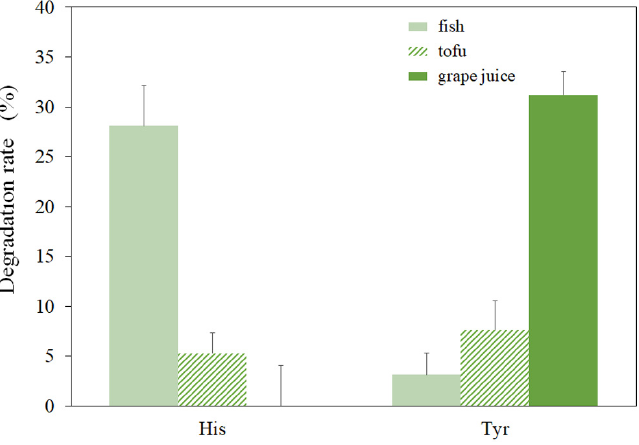
Figure 8. Effect of food matrices on the activity of rMCO towards histamine and